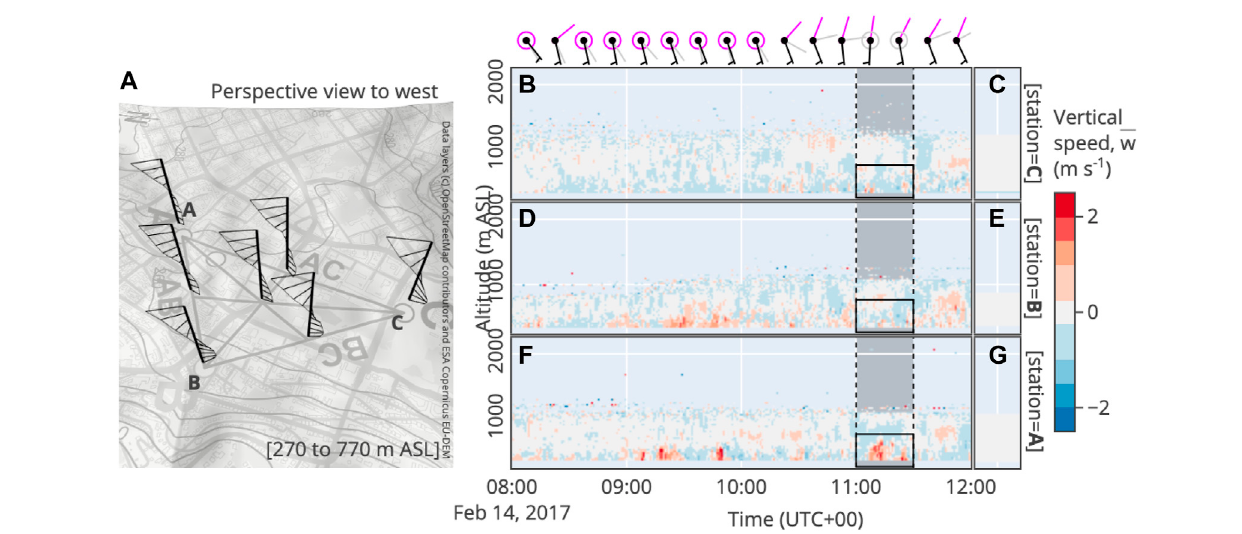
FIGURE 11 | Shown for locations in Stuttgart City Centre are (A) the mean wind pro fi les for the highlighted period and altitude range in the right panels in a perspective view with atopography background, and (B,D,F) the vertical wind speed against time and altitude above DL station locations “ A ” , “ B ” and “ C ” , and (C,E,G) the mean verticalwind speed against altitudefor the period between 08:00 and 12:00 UTC on 14 February 2017. Wind barbs shown on top represent the 15-min mean direction at 340 m, 530 and 720 m a.s.l., in magenta, grey and black, respectively.